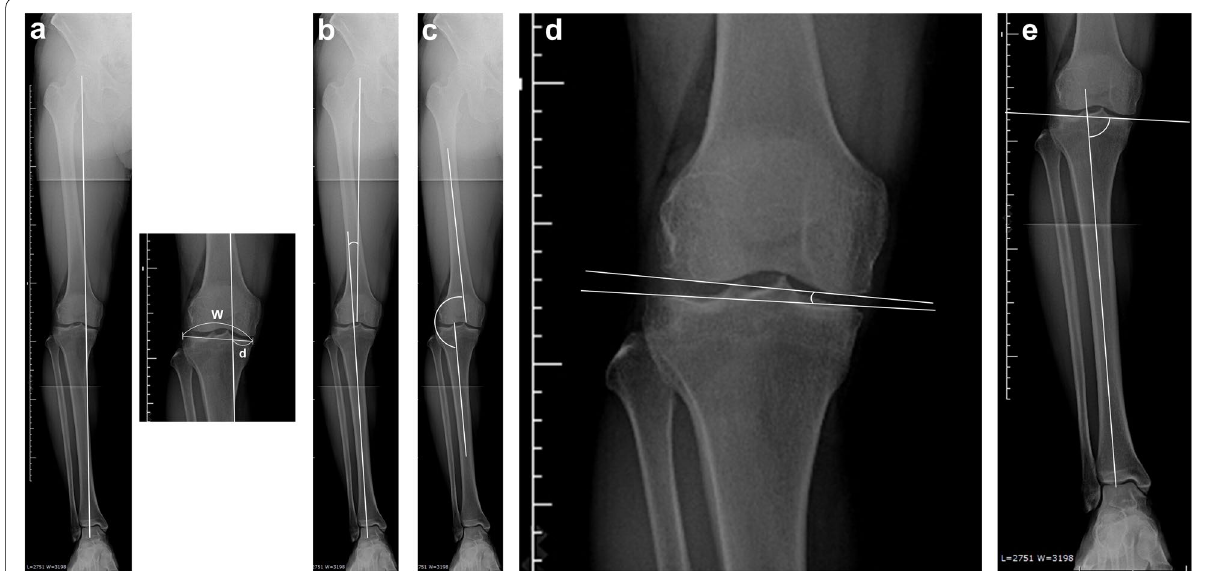
Fig. 1 Radiographic evaluation (bilateral standing whole-leg radiographs), a The weight-bearing line ratio (WBL ratio). The horizontal distance from the medial edge of the tibial plateau (d), divided by the width of the tibial plateau (W), as d/W regarded as 0% and the lateral edge as 100%, b Hip-knee-ankle angle (HKA), the angle formed by the mechanical axis of femur and tibia. Negative values are assigned to knees with varus alignment, c Femoro-tibial angle (FTA), d Joint line convergence angle, e Medial proximal tibial